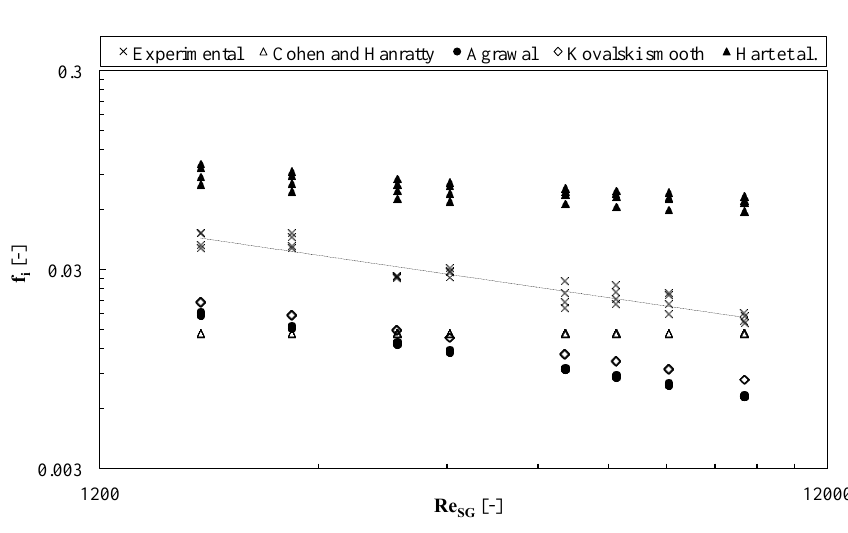
Figure 13. Interfacial friction factor vs. superficial gas Reynolds number.